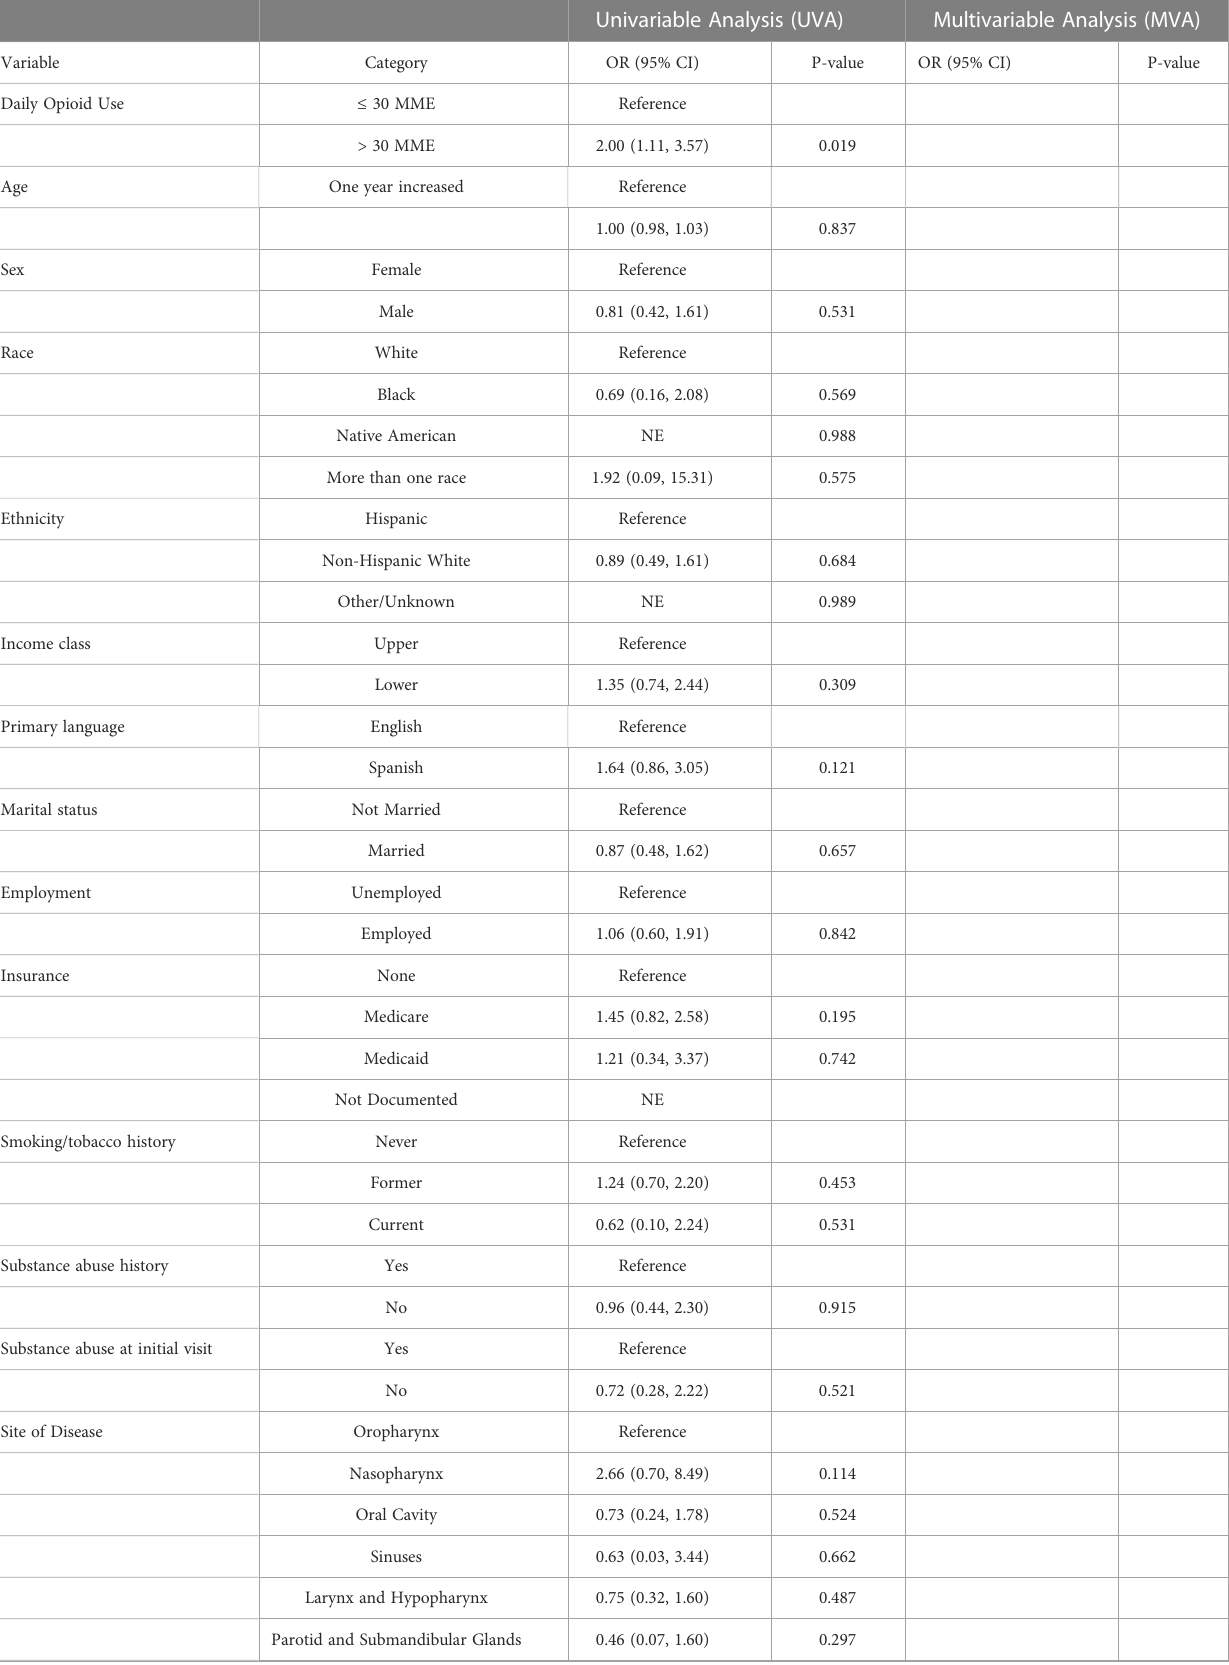
TABLE 3 Factors In fl uencing Hospital